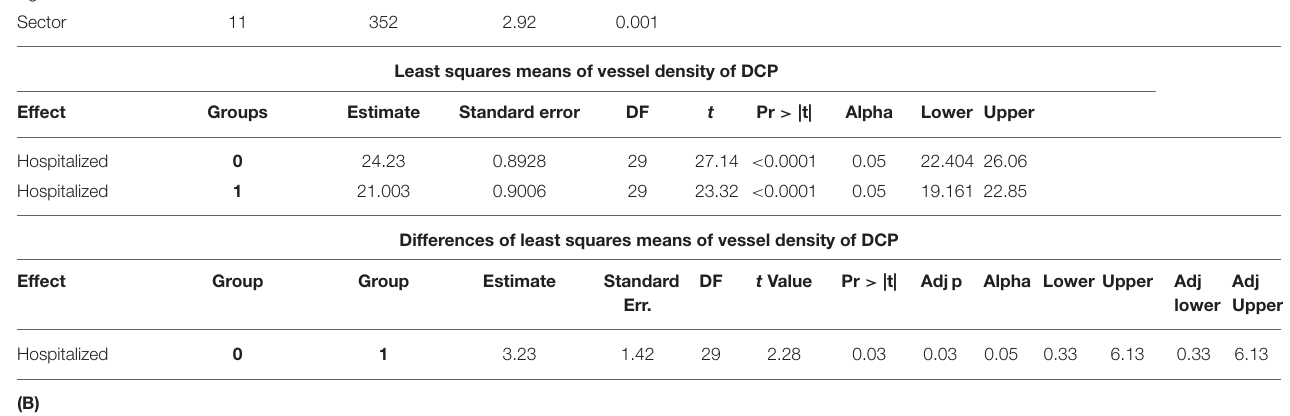
Least squares means of c 3 of DCP for effect groups